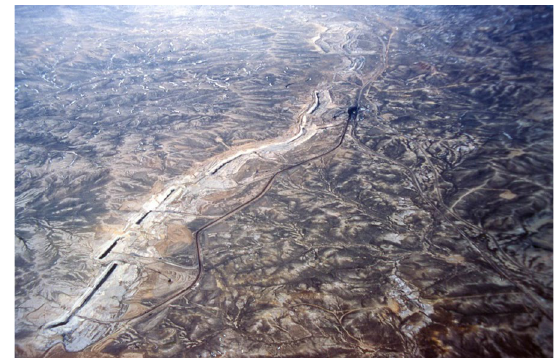
Fig. 5 Aerial view of the mine in 1975